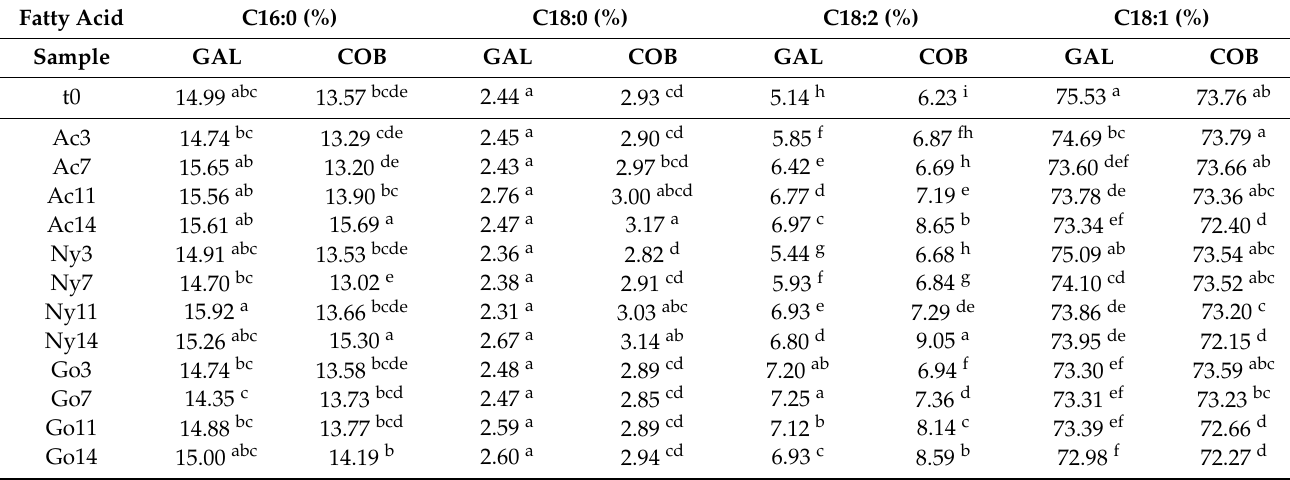
Table 2. Mean values of the major fatty acid composition (palmitic (C16:0), stearic (C18:0), oleic (C18:1), and linoleic acids (C18:2)) of Galega (GAL) and Cobrançosa (COB) VOO obtained from fruits inoculated with Colletotrichum acutatum (Ac), C. nymphaeae (Ny), and C. godetiae (Go), at 0, 3, 7, 11, and 14 days of incubation. Superscript indexes indicate